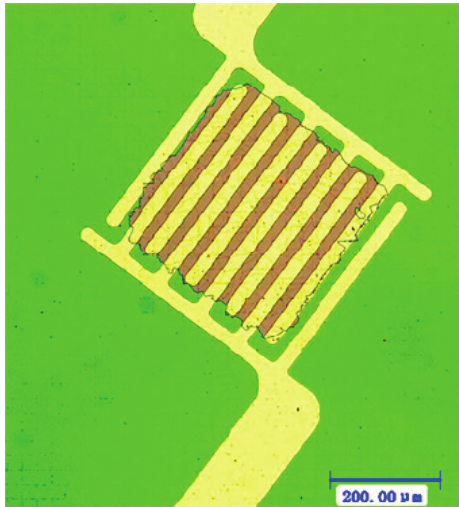
Figure 3. Optical microscope images of micro interdigitated electrodes on the sensitive film.